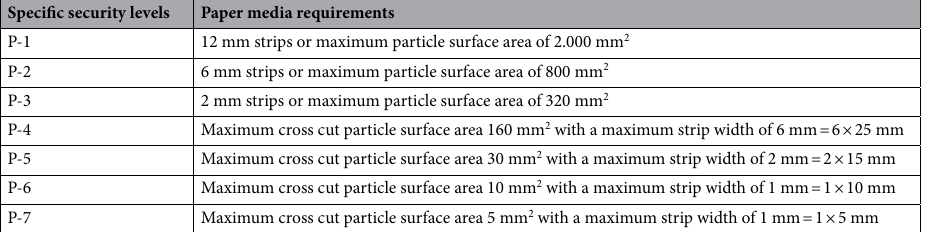
Table 1. Requirements for machines and processes shredding documents (DIN